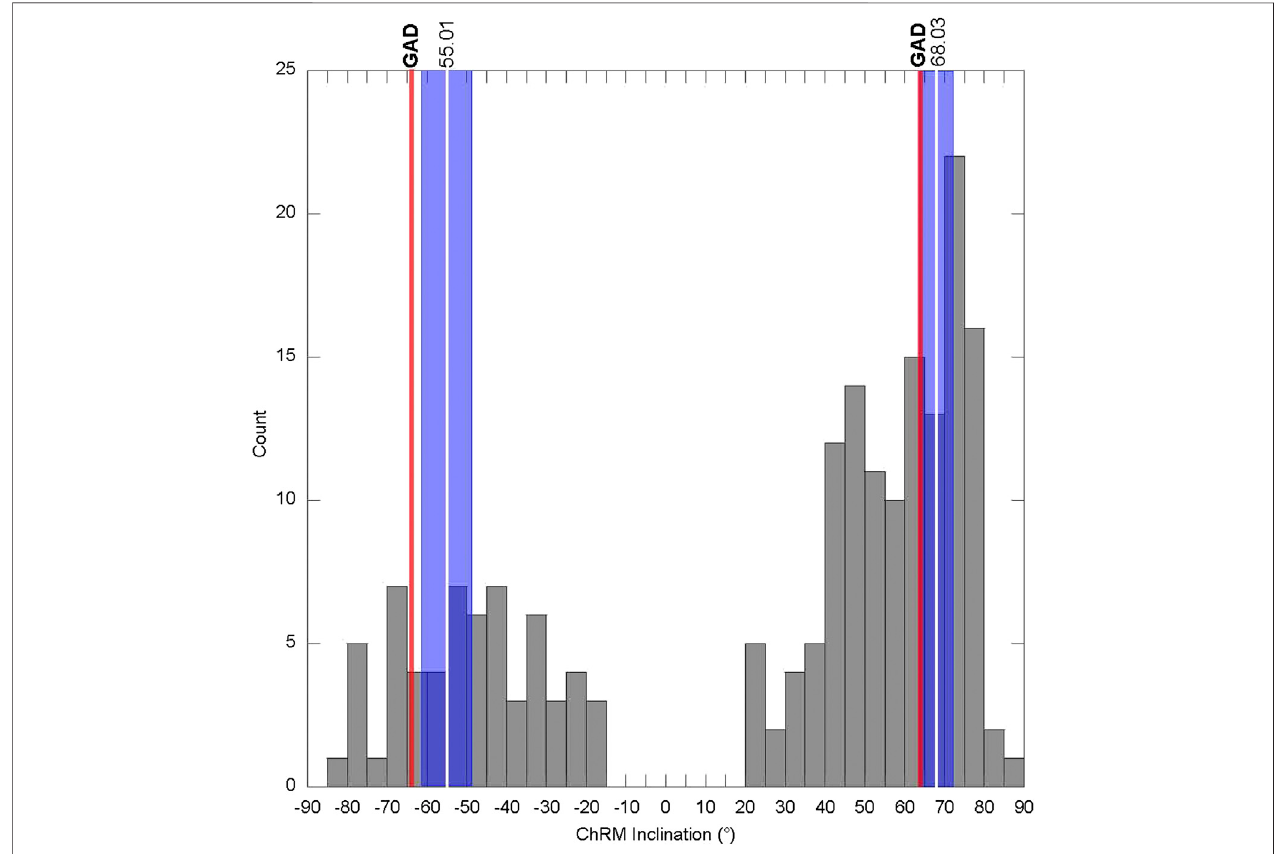
FIGURE5| HistogramsofpaleomagneticinclinationsfromdiscretesamplesforDSDPSite274afterAFdemagnetization.MeanChRMinclinations(showninblue), and associated α 95 , were computed separately for normal and reverse polarity populations using a maximum likelihood method (Arason and Levi, 2010). The expected inclinations for the GAD are shown in red for this period and for the site latitude (Torsvik et al., 2012).